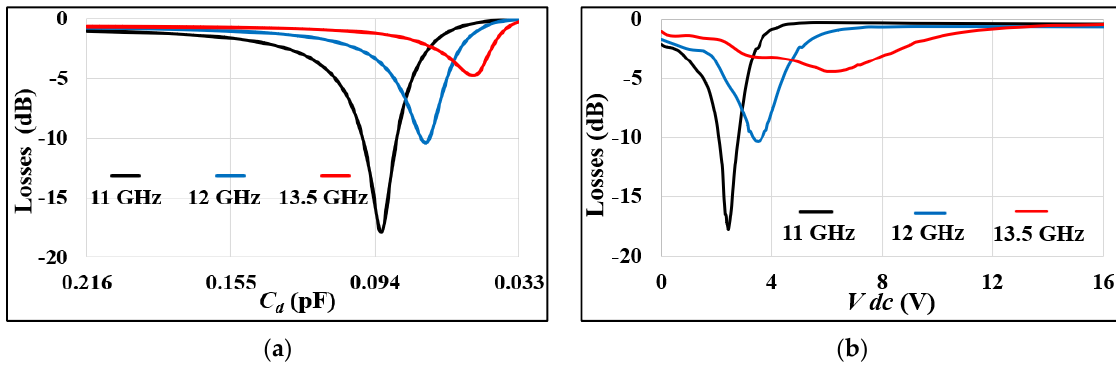
Figure 13. Reflection losses as a function of the varactor reverse bias for 11 GHz, 12 GHz, and 13.5 GHz from left to right, respectively: ( a ) reflection losses simulation results and ( b ) reflection losses measurement results.